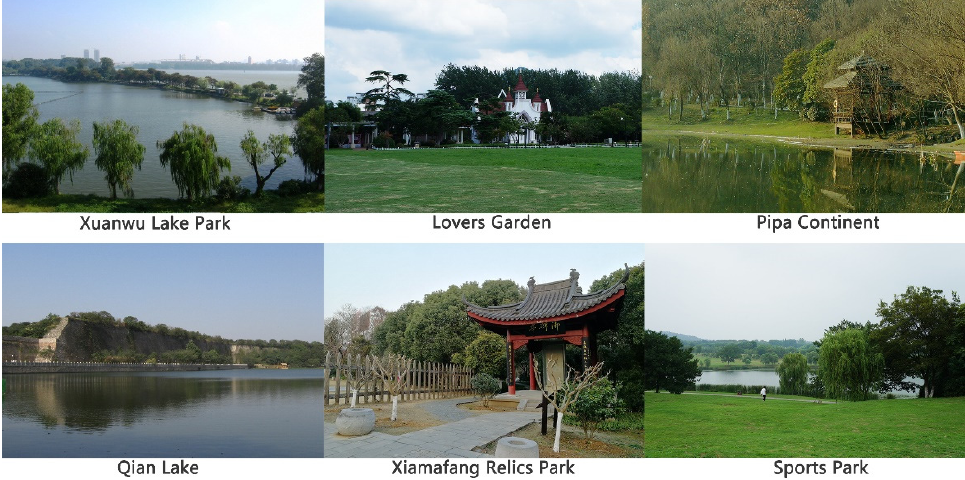
Figure 2. Photos of the six urban parks included in the study.